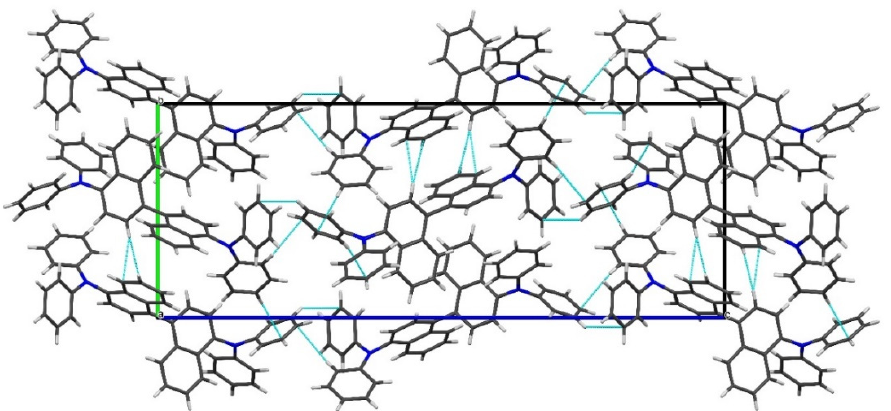
Figure 5. Fragment of the crystal packing of N , N , N ’, N ’-tetraphenylnaphthidine ( 4 ) showing the unit cell and C–H ··· π interactions (view along the a -axis of the crystal).